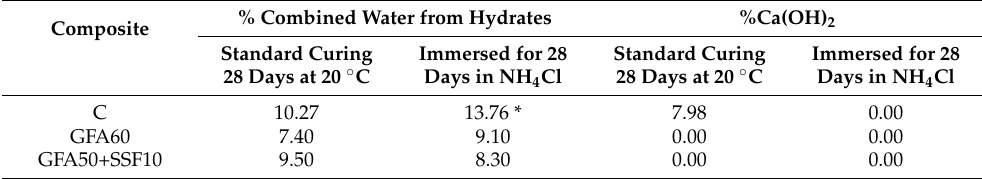
Table 7. Thermogravimetry results for the composites immersed in a 1 M NH 4 Cl solution. Composite